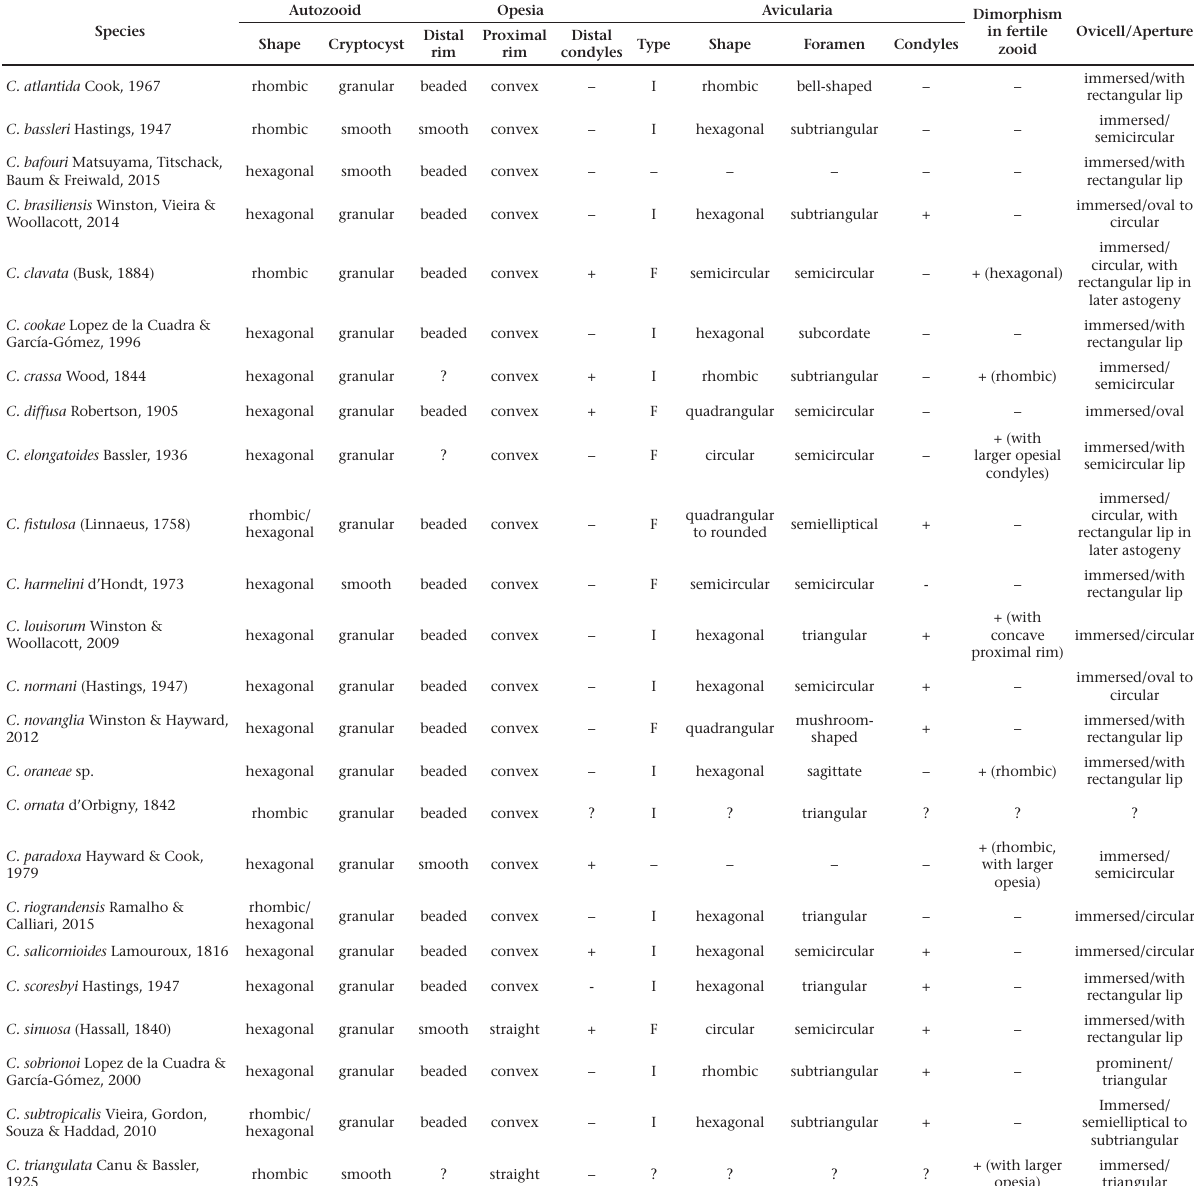
Table 1. Tabular identification key to Atlantic species of Cellaria : present (+) and absent (–), avicularia interzooidal (I), avicularia fistulose (F), unknown states